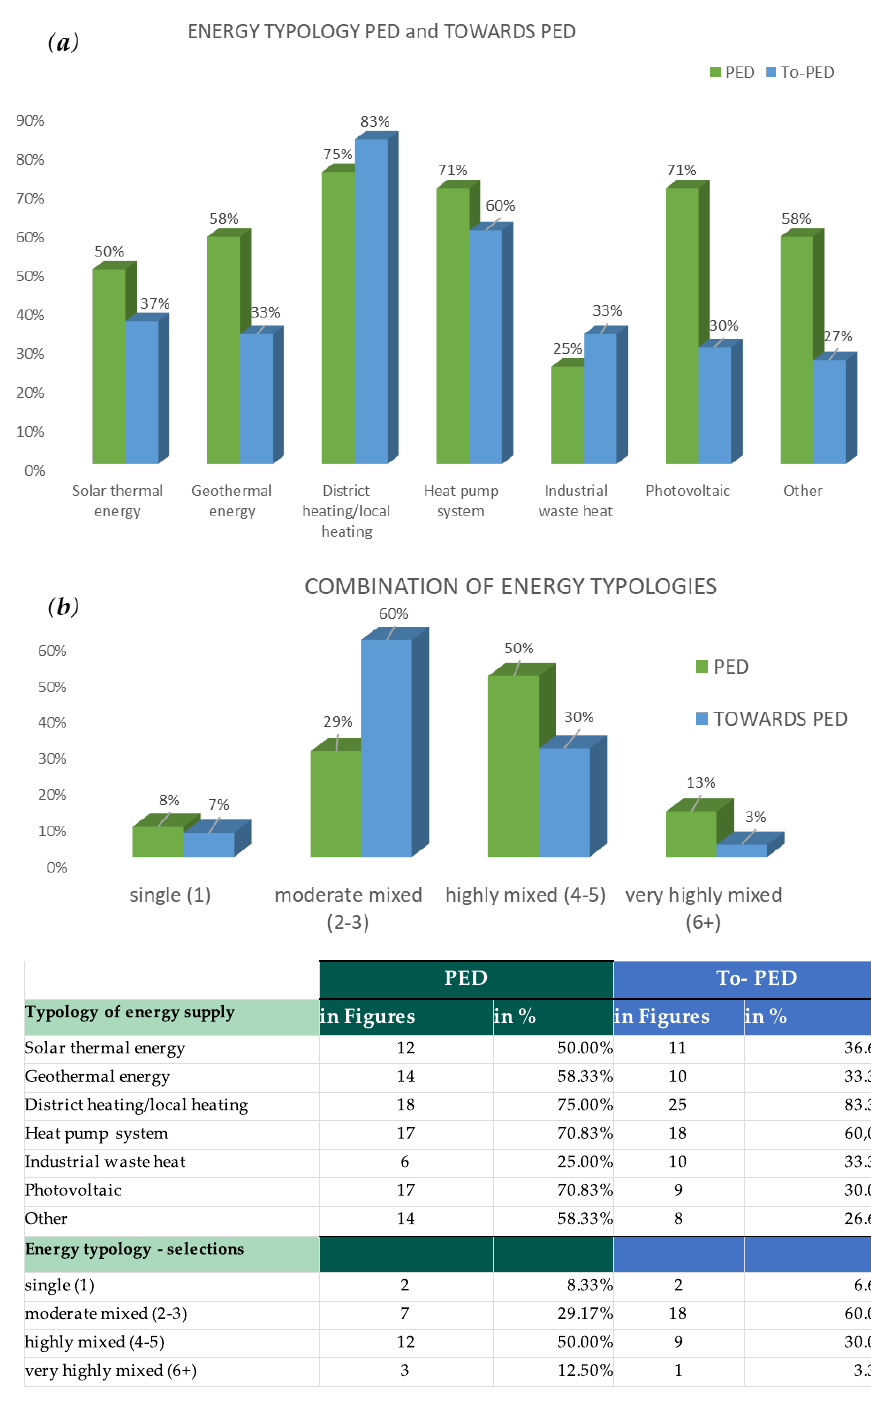
Figure 4. ( a ) Energy typology of PED versus To-PED; ( b ) energy typology selections of PED versus To-PED.